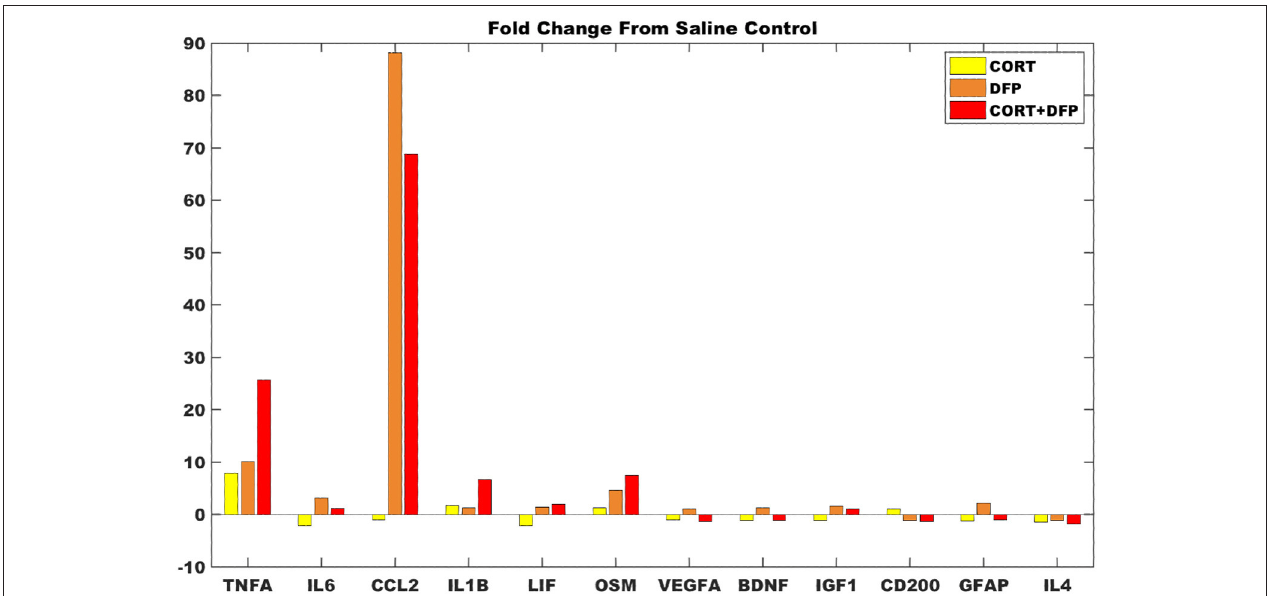
FIGURE 4 | Gene expression changes in mouse cortex for exposure conditions compared to control. Fold change in marker gene expression levels from RNAseq of samples collected at 6h relative to resting saline control for data obtained in cortex for the subset of 12 markers represented in the logic circuit model.